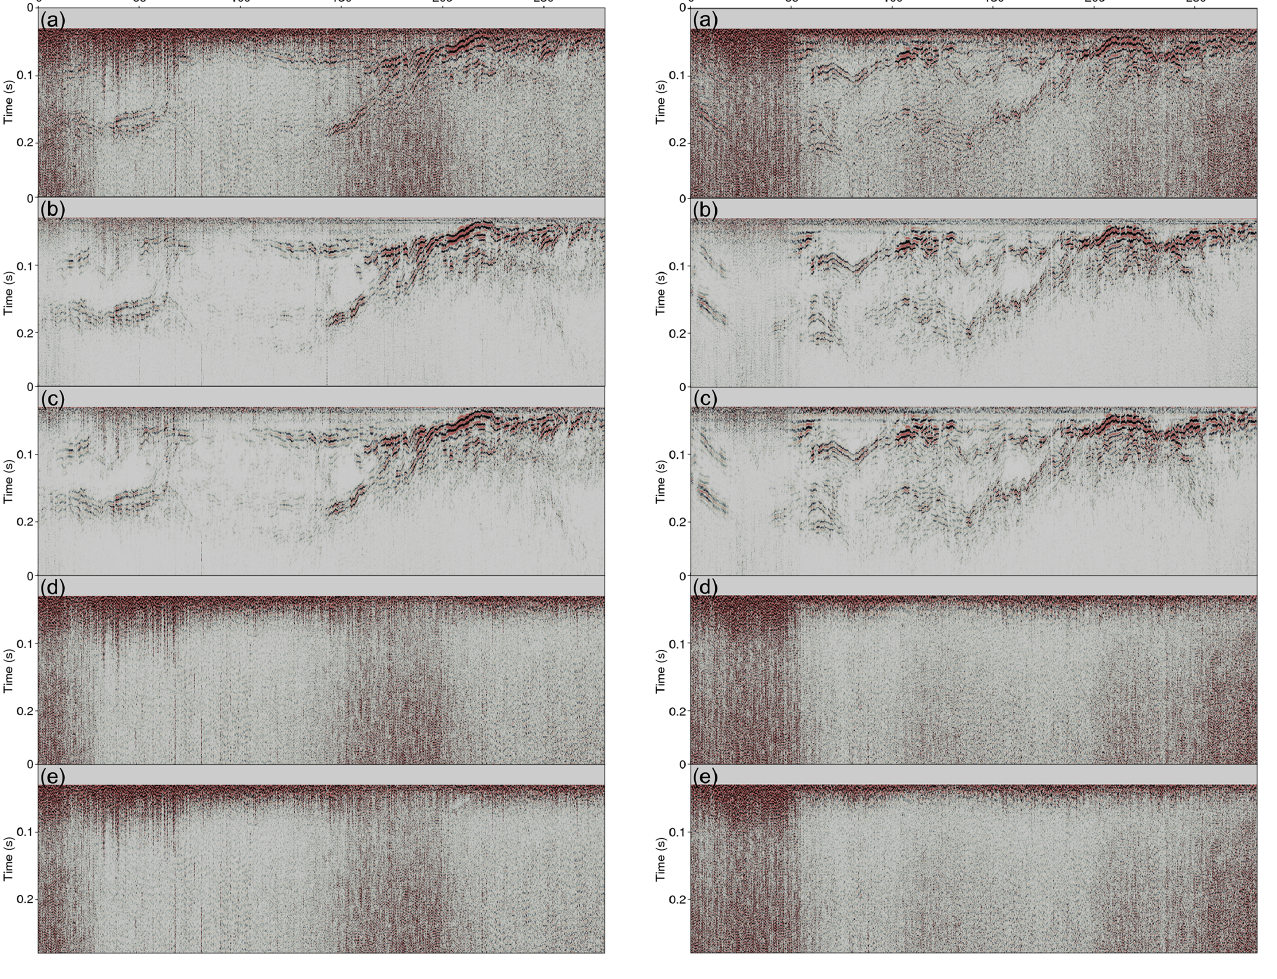
Figure 18. (a) Line 1 seismic section before applying DnCNN, noise-attenuated result using (b) the D1 model and (c) the D2 model, and estimated noise using (d) the D1 model and (e) the D2 model.